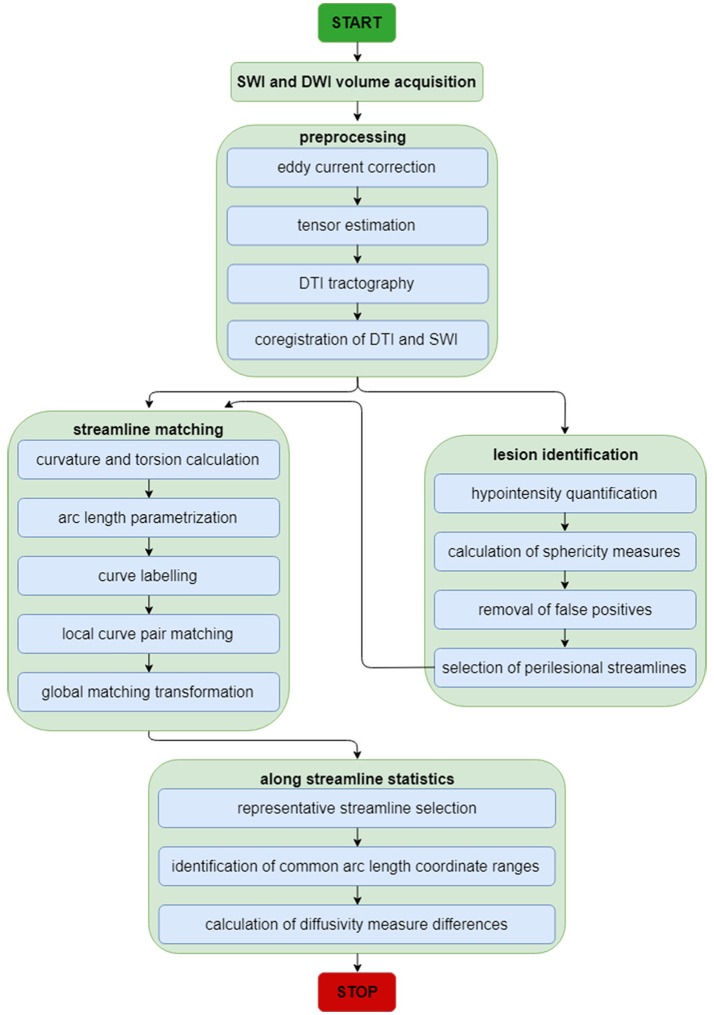
Neuroimage analysis flowchart for SWI and DWI volumes. The flowchart summarizes the analytic steps described in the Methods section, to which the reader is referred for details. Briefly, after standard pre-processing of SWI and DWI volumes, DTI streamlines and SWI volumes are each used for streamline matching and lesion identification, respectively. After the latter operation, the parameters of identified lesions are used as additional input to the streamline matching process. Once streamlines have been matched, statistics of interest are computed along streamlines.